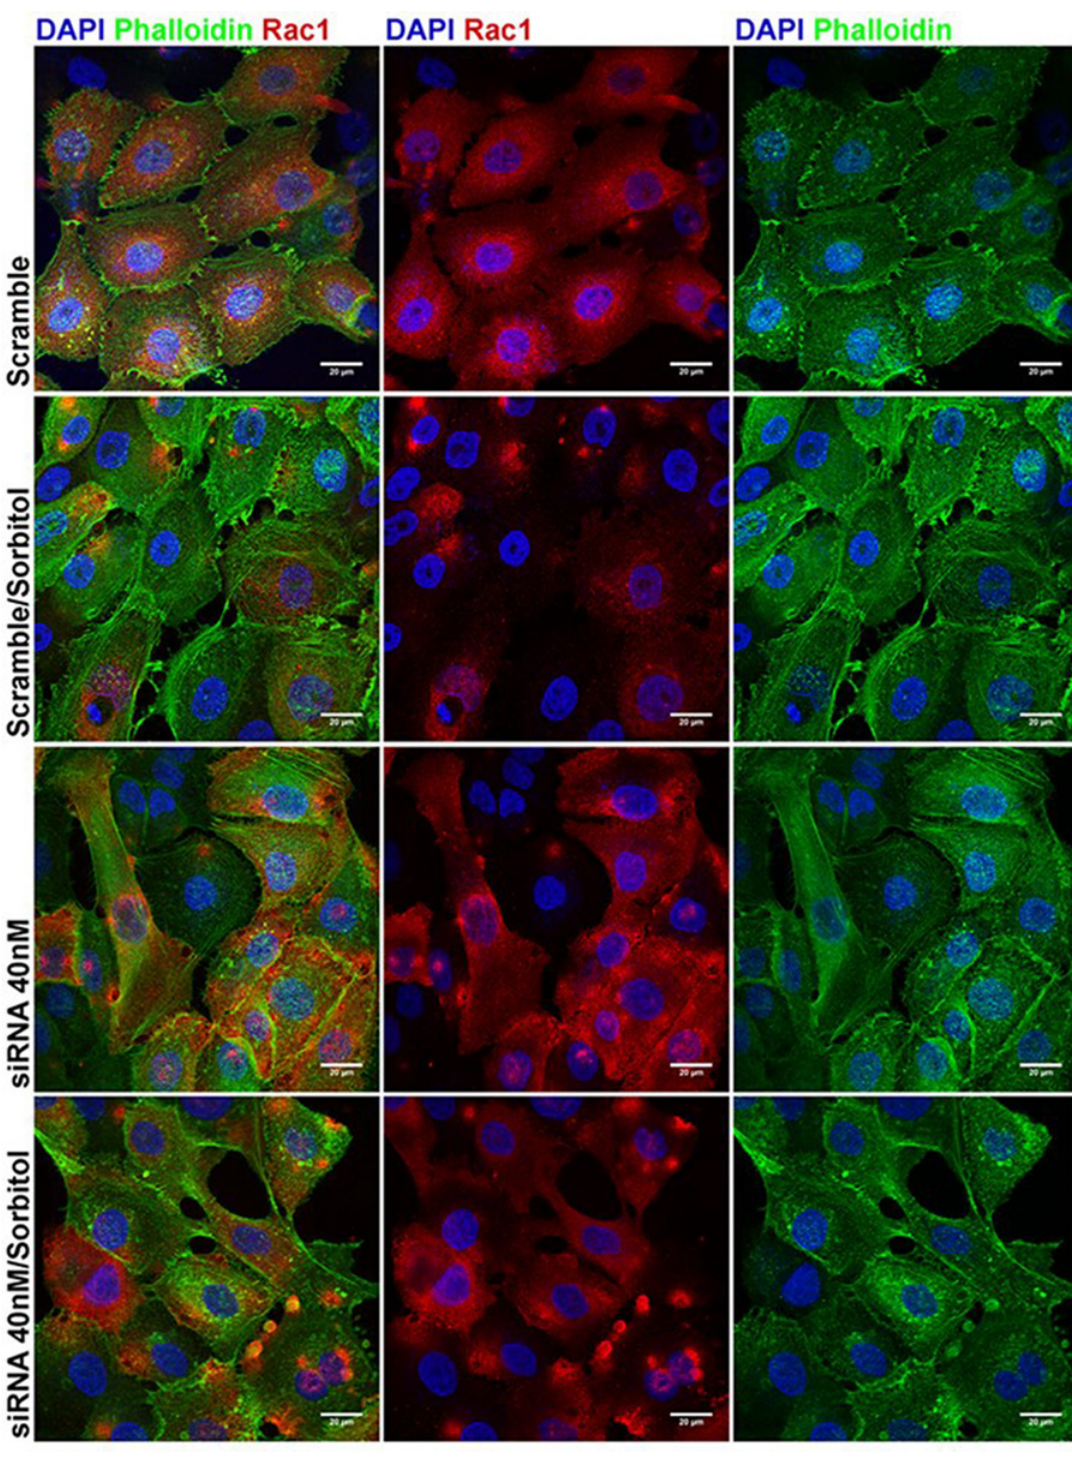
Fig 6. Rac-1 and F-actin staining in LMWPTP silenced HaCaT cells. HaCaT cells were transfected with siACP1-CV 40 nM and exposed to 1 M sorbitol for 2 h. Rac-1 distribution and the organization of the actin filaments (F-actin) were evaluated by laser confocal microscopy after incubation of the cells with specific antibody for Rac-1, followed by staining with Alexa Fluor 594 goat anti-rabbit IgG antibody (red), and Alexa Fluor 488-conjugated phalloidin (green). The nuclei were stained with DAPI (blue). Bar = 20 μ m. Representative results of 3 independent experiments.